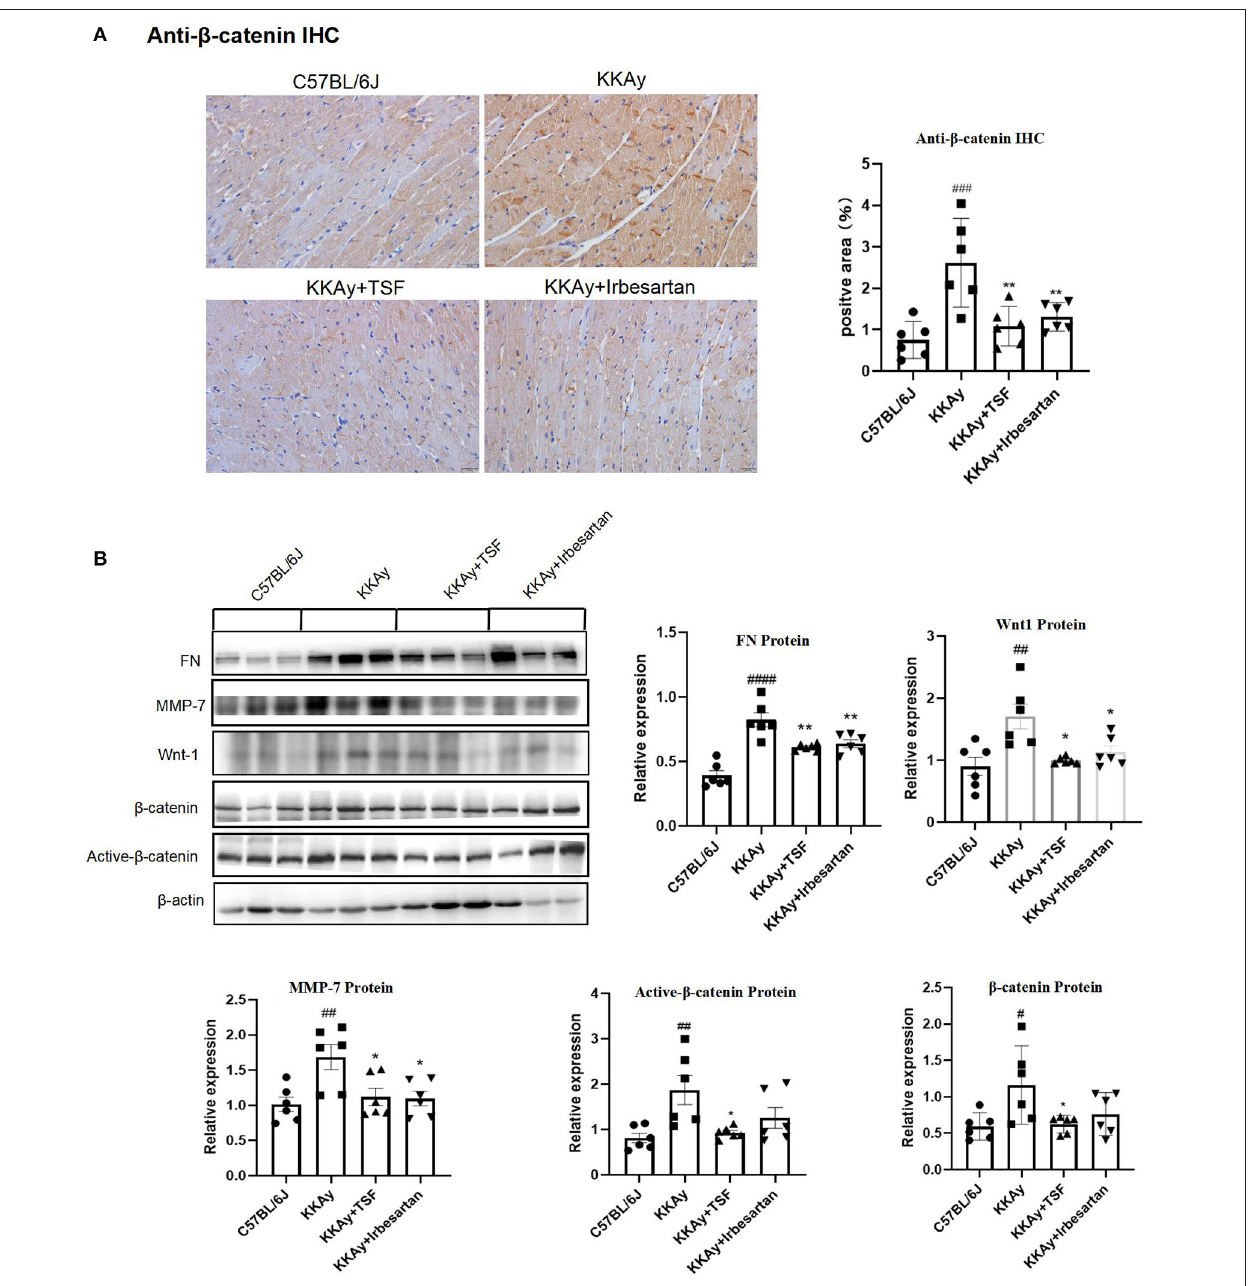
FIGURE 4 | An effect of TSF on the canonical Wnt pathway. (A) IHC of anti- β -catenin (original magnification, 200 × ). Data are presented as mean ± SEM. * p < 0.05, ** p < 0.01 TSF-treated group vs. KKAy group; # p < 0.05, ## p < 0.01, ### p < 0.001 KKAy group vs. C57BL/6J group. (B) Western blot analyses and semi-quantitative analyses revealed expressions of Wnt1, active- β -catenin, β -catenin, FN, and MMP-7 in KKAy mice and the different treatment groups. # p < 0.05, ## p < 0.01, ### p < 0.001, #### p < 0.0001 KKAy group vs. C57BL/6J group. * p < 0.05, ** p < 0.01 TSF-treated group vs. KKAy group.